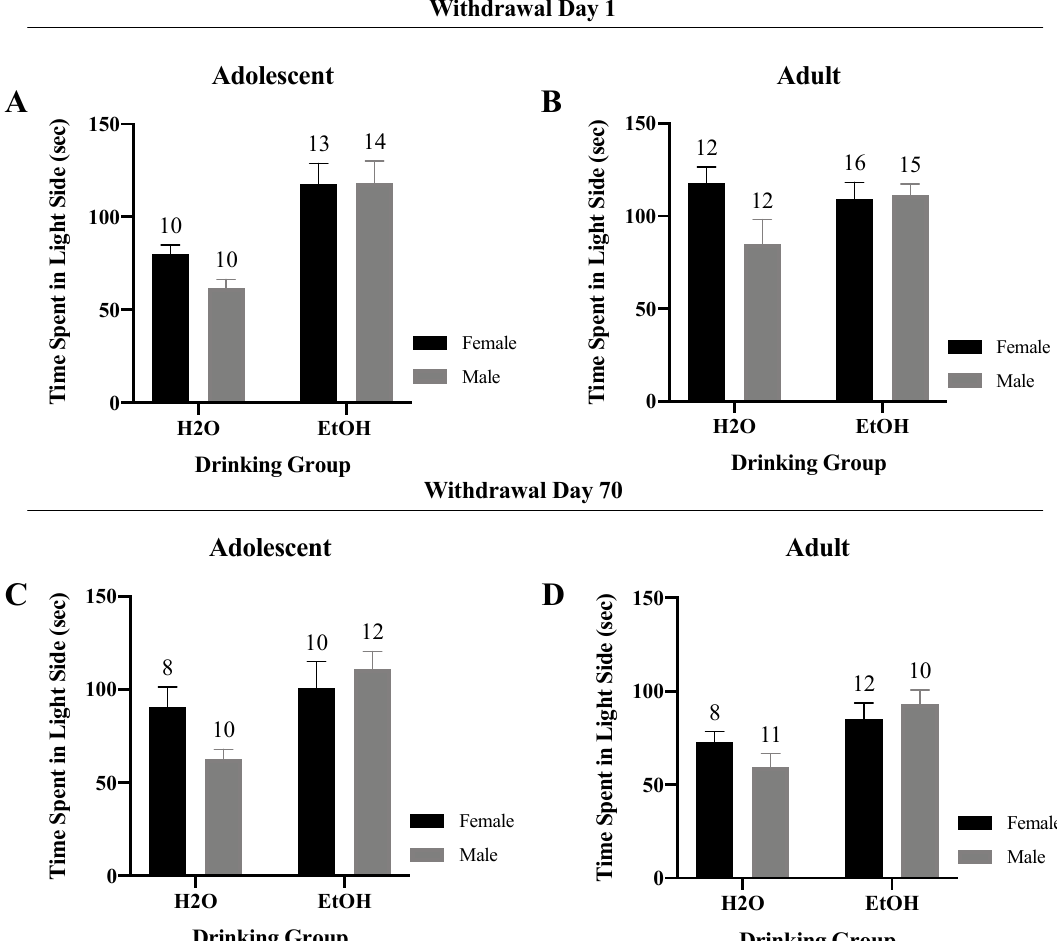
Figure 4. Summary of the results for the Sex × Drinking ANOVA observed for the total time spent in the light-side in the light–dark shuttle-box test. ( A ) Depiction of the results for the adolescent-onset mice at 1-day withdrawal. ( B ) Depiction of the results observed for the adult-onset mice at 1-day withdrawal. ( C ) Depiction of the results for the adolescent-onset mice at 70-days withdrawal. ( D ) Depiction of the results for the adult-onset mice at 70-days withdrawal. The data represent the means ± SEMs for the numbers of mice indicated in each panel.